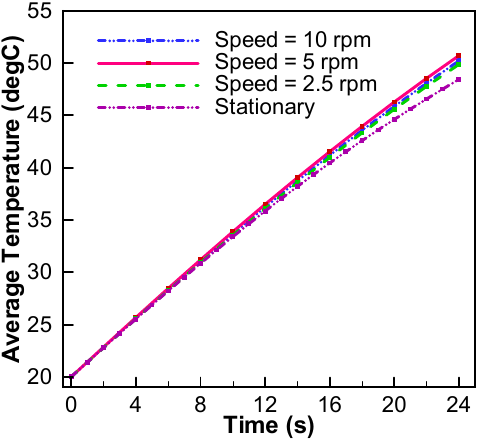
Figure 13. The average temperatures of the cubic potato heated with different rotational speeds.